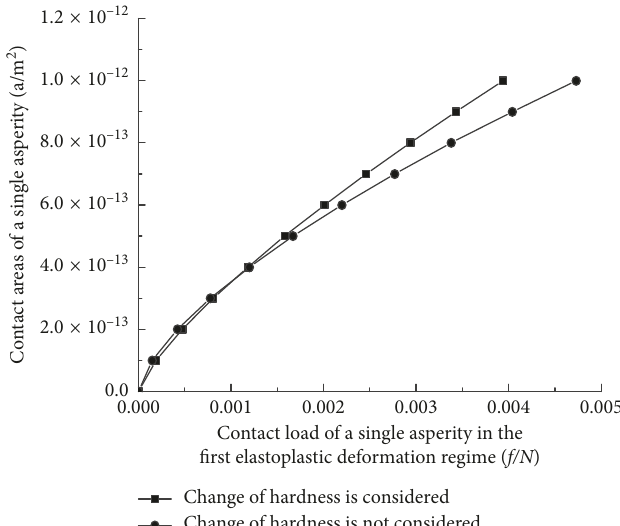
Figure 4: The relationship between contact load and contact area of single asperity in the first elastoplastic deformation stage.